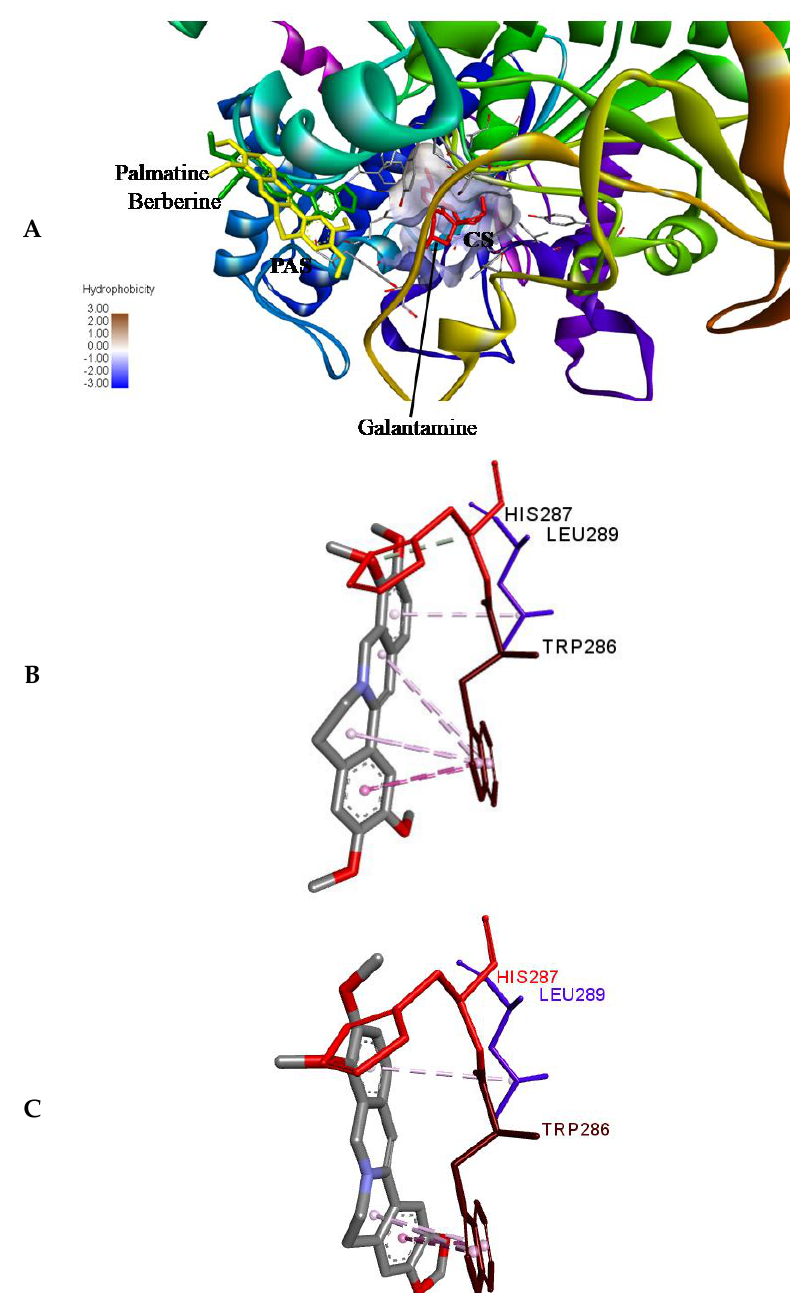
Figure 6. ( A ) Binding pose of palmatine, berberine, and galantamine (re-docked) onto AChE (PDB ID: 4EY6). Palmatine and berberine prefer the peripheral anionic site (PAS). CS, catalytic site. ( B ) Non-bonded interactions of ( B ) palmatine and ( C ) berberine in PAS; π-interaction to PAS residue Trp286 in AChE.